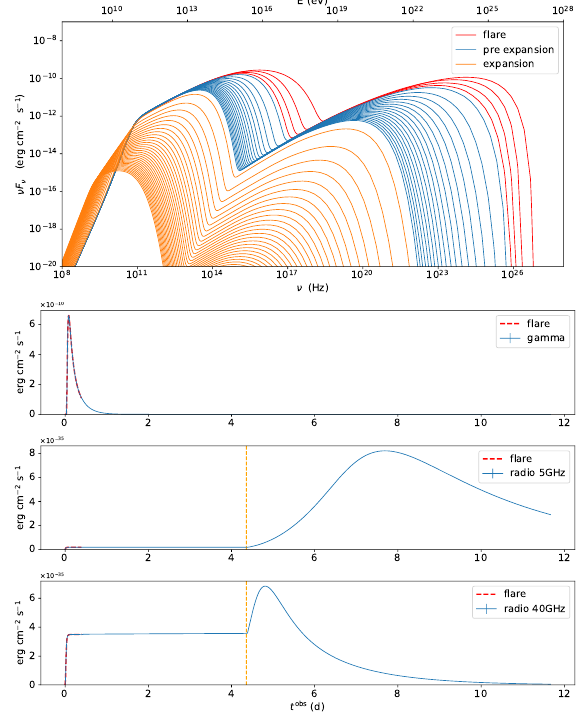
Figure 4. Top panel : time-resolved SEDs, computed with Jetset, for a flaring stage (red lines) followed by a pre-expanding stage (blue lines) and an adiabatic expansion stage (orange lines) with β exp = 0.1. The three bottom panels show the corresponding light curves at high energies, and in the radio at 5 and 40GHz. The red dashed lines mark the light-curve segment belonging to the flaring stage, the orange vertical dashed lines mark the beginning of the expansion, and the orange line marks the expansion stage. Adapted from